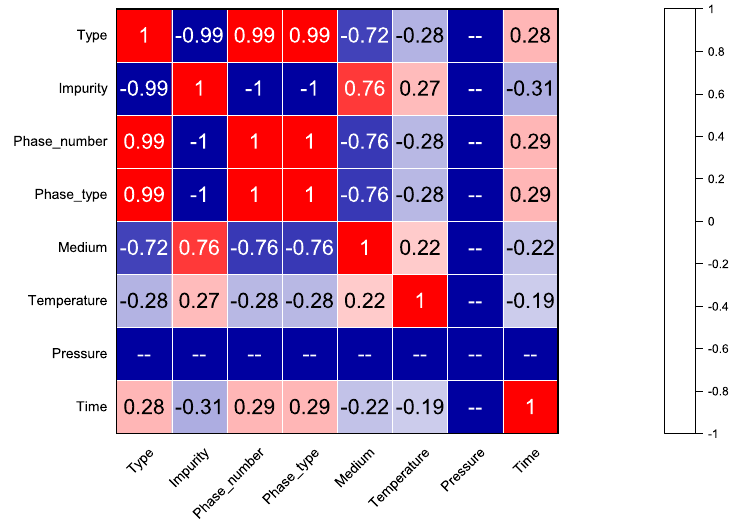
Figure 5. The Pearson correlation map of input features.